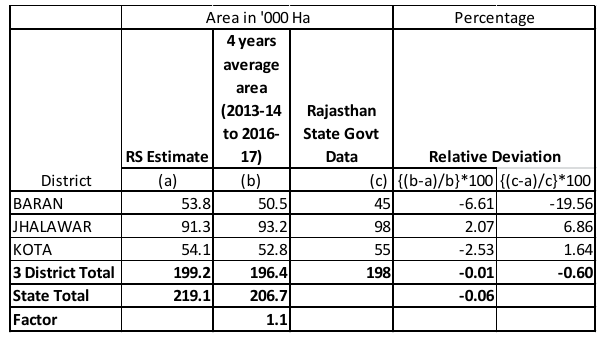
Table 4. Area Comparison between Remote Sensing Estimate and Government Data ( Source: